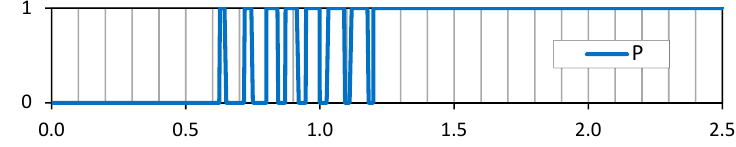
Figure 3. Performance of the elements of the boiler during the combustion test for LAB2 pellets.